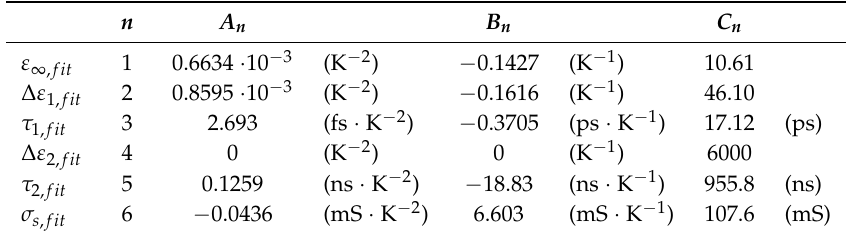
Table 1. Temperature coefficients of the second order polynomial fit to the temperature dependent Cole-Cole parameters of